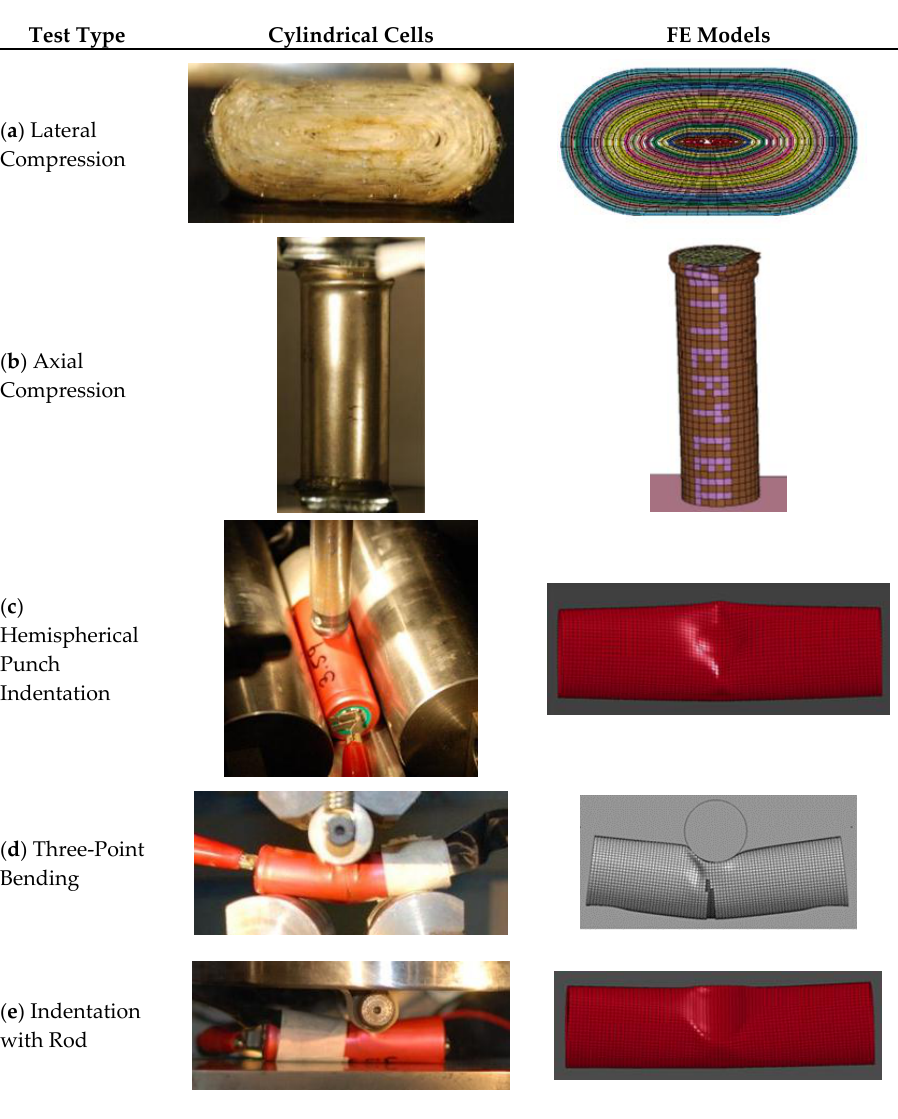
Figure 5. Experimental setup and deformation of cylindrical cells and the corresponding finite element models. The figures are from the study presented in [35,69]. ( a ) Lateral Compression; ( b ) Axial Compression; ( c ) Hemispherical Punch Indentation; ( d ) Three-Point Bending; ( e ) Indentation with Rod